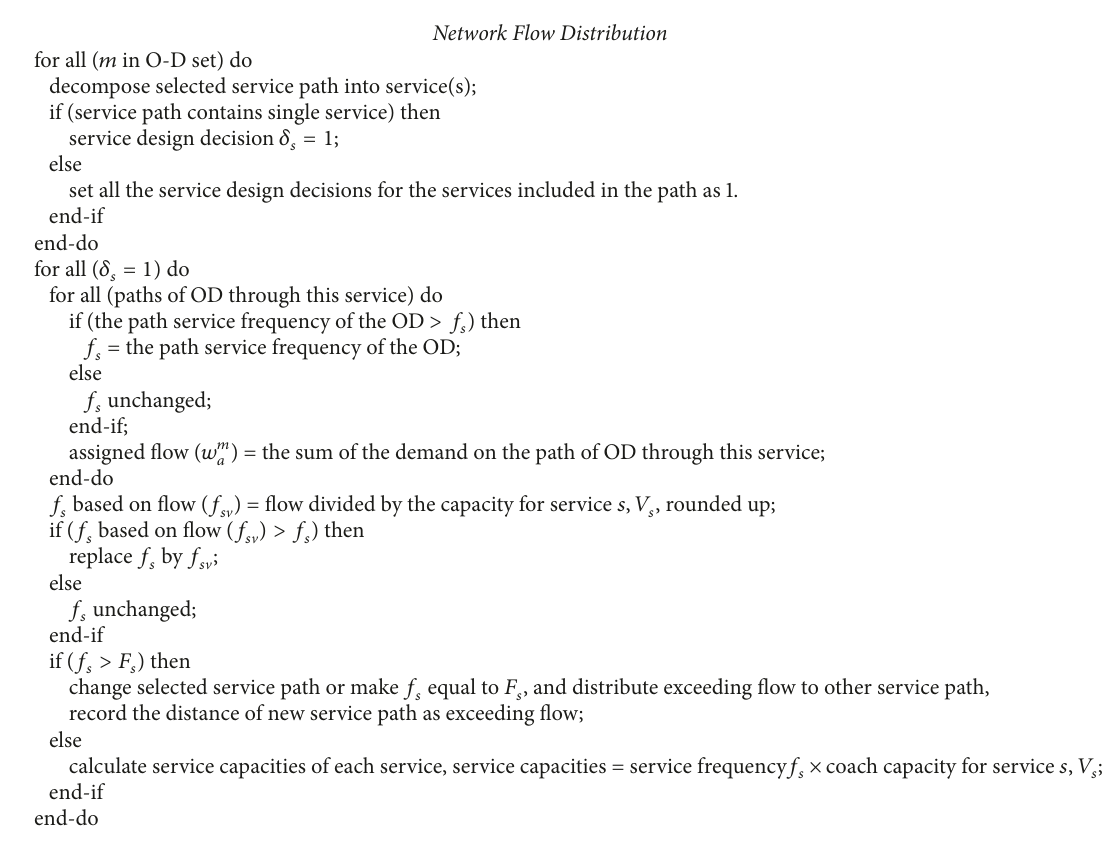
Pseudocode 3: Pseudocode for network flow